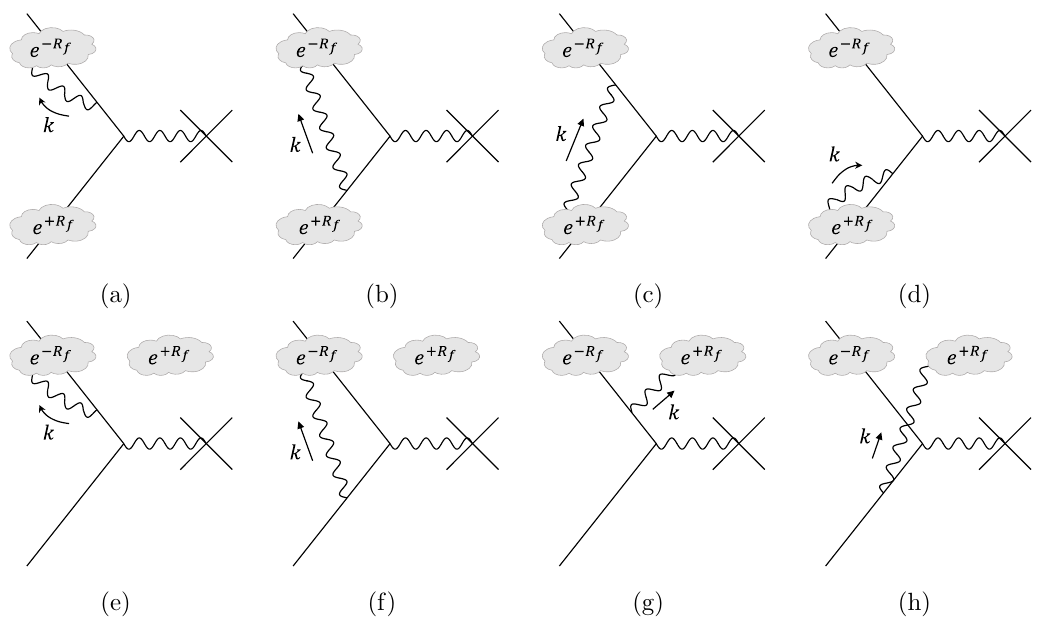
Figure 1. Diagrams (a)-(d) represent processes with Faddeev-Kulish asymptotic states. Diagrams (e)-(h) represent the same processes with the incoming cloud moved to the outgoing state. Notice the \wrong" sign + R f compared to a normal outgoing cloud with (cid:0) R f